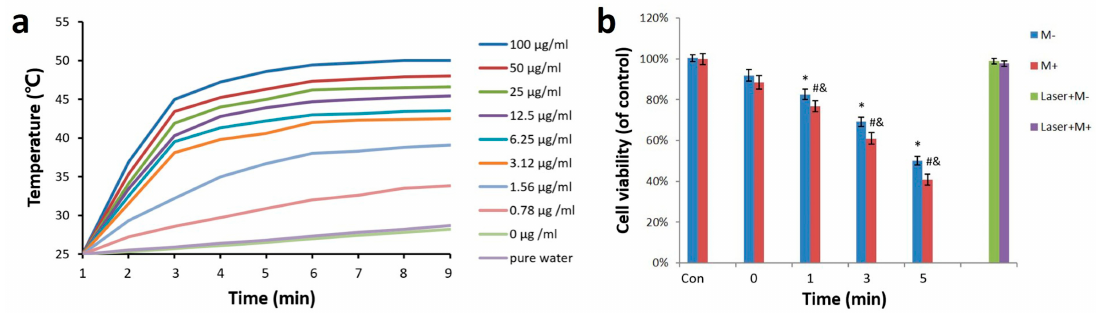
Figure 4. Photothermal conversion capacity of Fe 3 O 4 @Au NPs. ( a ) Temperature increase at different concentrations of Fe 3 O 4 @Au NPs after different irradiation times; ( b ) HeLa cell viability after incubation with Fe 3 O 4 @Au NPs for 0, 1, 3, and 5 min NIR irradiation. *, # p < 0.05 versus control group, & p < 0.05 versus non-magnetic group.